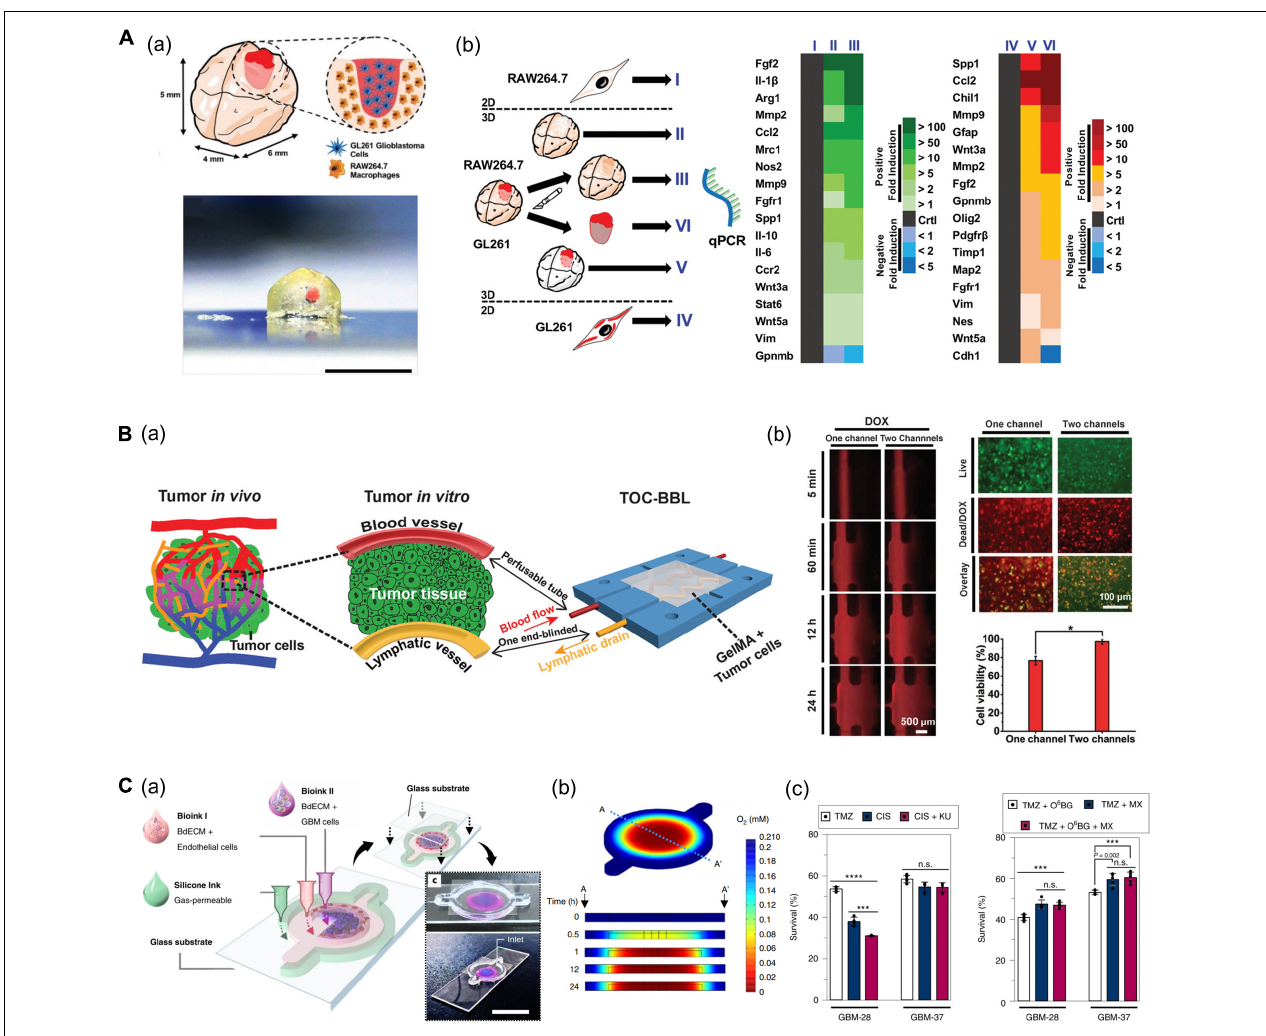
FIGURE 7 | (A) GBM model based on a 3D bioprinted mini-brain construct containing macrophages. (a) Schematic and picture of GBM model exhibit GBM area in red on the bioprinted mini-brain. (b) Schematic illustrates the experimental conditions for the bioprinted RAW264.7/GL261 co-culture model and heatmap shows distinguished gene expression as a 2D monolayer (I and IV), 3D single bioprinted (II and V), and 3D bioprinted RAW264.7/GL261 co-culture model (III and VI) in RAW264.7 and GL261 glioblastoma. Reprinted with permission from Heinrich et al. (2019). (B) In vitro cancer model consisting of a pair of blood vessels and lymphatic vessels using 3D bioprinting. (a) Schematic shows the design of a bioprinted cancer model containing a pair of blood/lymphatic vessels that mimic actual TME. (b) Images on the left show the diffusion of DOX in a 1-channel/2-channel configuration, and the fluorescence images on the right exhibit cell viability for 24 h after DOX delivery (* p < 0.01). Reprinted with permission from Cao et al. (2019). (C) Application of patient-derived cell for in vitro GBM model mimicking hypoxic TME. (a) Schematic describes the design of GBM-on-a-chip with a compartmentalized cancer-vascular structure. (b) Colormap image of the oxygen